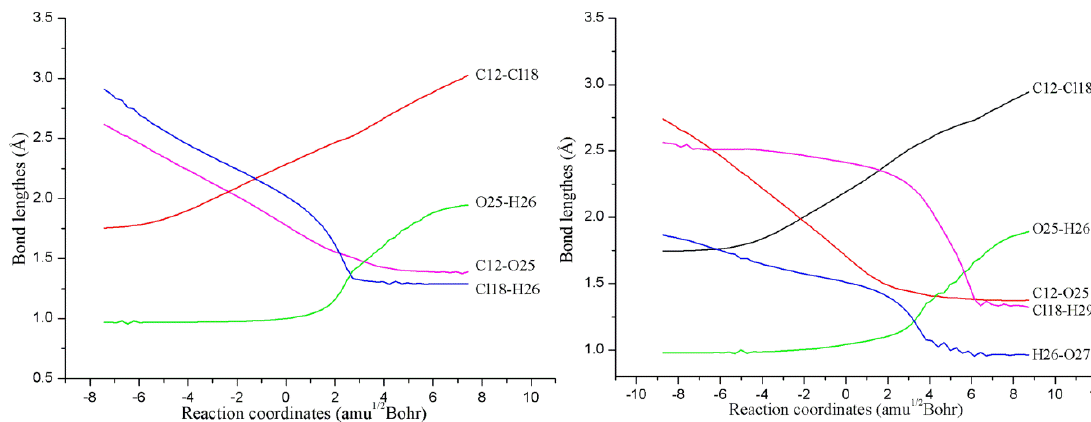
Figure 3. Variations of the selected bond lengths along with the IRC of the transition states TS1(0w) ( left ) and TS1(1w) ( right ).